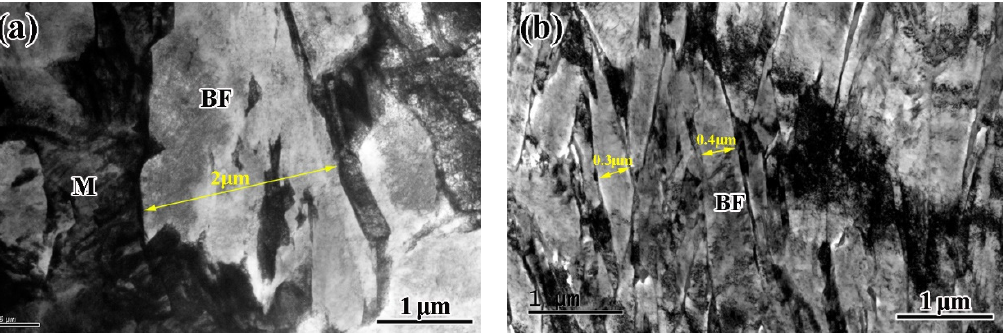
Figure 4. TEM images of the microstructure of 1280G and 1380G rail steels. ( a ) 1280G; ( b ) 1380G; BF: bainite ferrite, M: martensite.